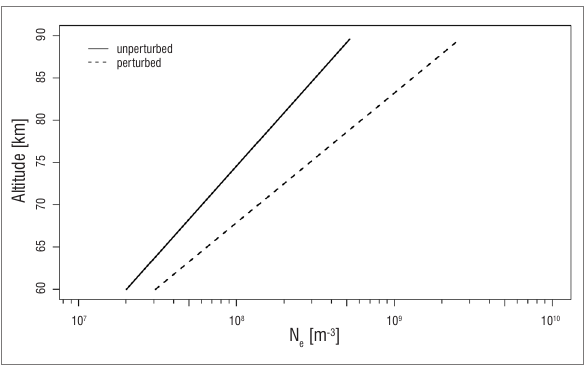
Figure 5: Modelled electron density profile on 13 December 2007 for the quiet and perturbed ionosphere. From the calculated values for H ˈ and β the variations in amplitude and phase versus distance were calculated using LWPC and are presented in Figure 6. The vertical solid lines indicate the distances from the transmitters to the receivers. Generally, all the modal minima were found to move towards the transmitter during a flare. 9 There are certain locations close to a modal minimum that are more sensitive to the effects of the flare, with the result that a greater variation of the signal is observed at these locations. For the GBZ transmitter (Figure 6a), the Gyergyóújfalu receiver was more sensitive to the flare than was the receiver at Budapest. The phase variation along the GQD path (Figure 6b)